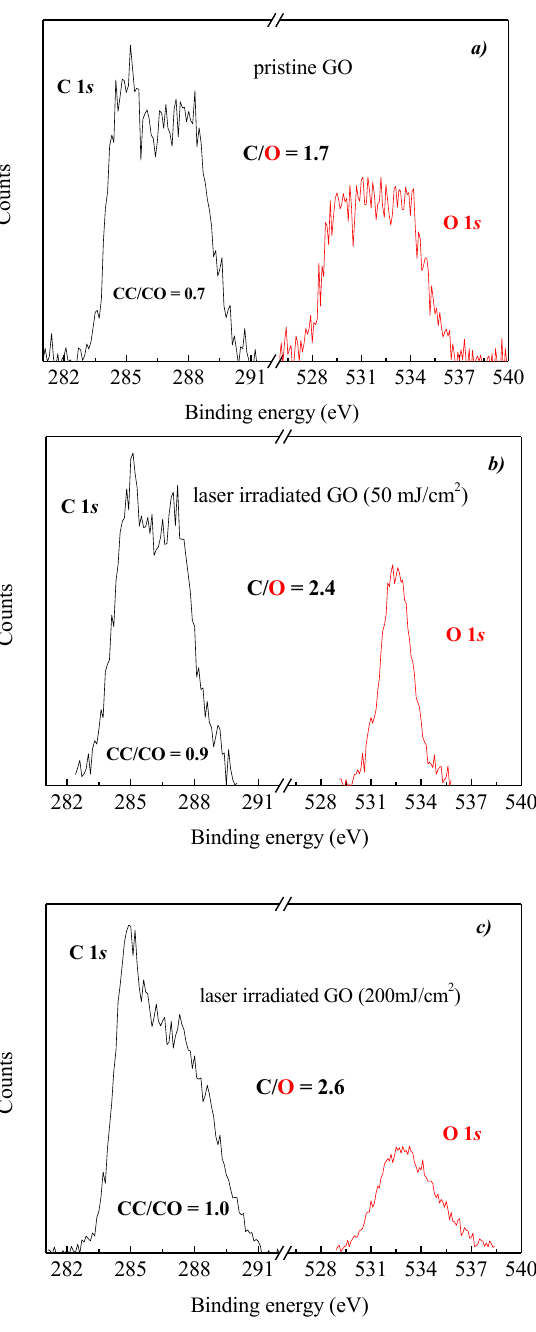
Fig. 6. Comparison of the C1s and O1s core level XPS spectra revealed for the pristine GO ( a ) and laser irradiated GO foils at 50 mJ/cm 2 ( b ) and 200 mJ/cm 2 ( c ).